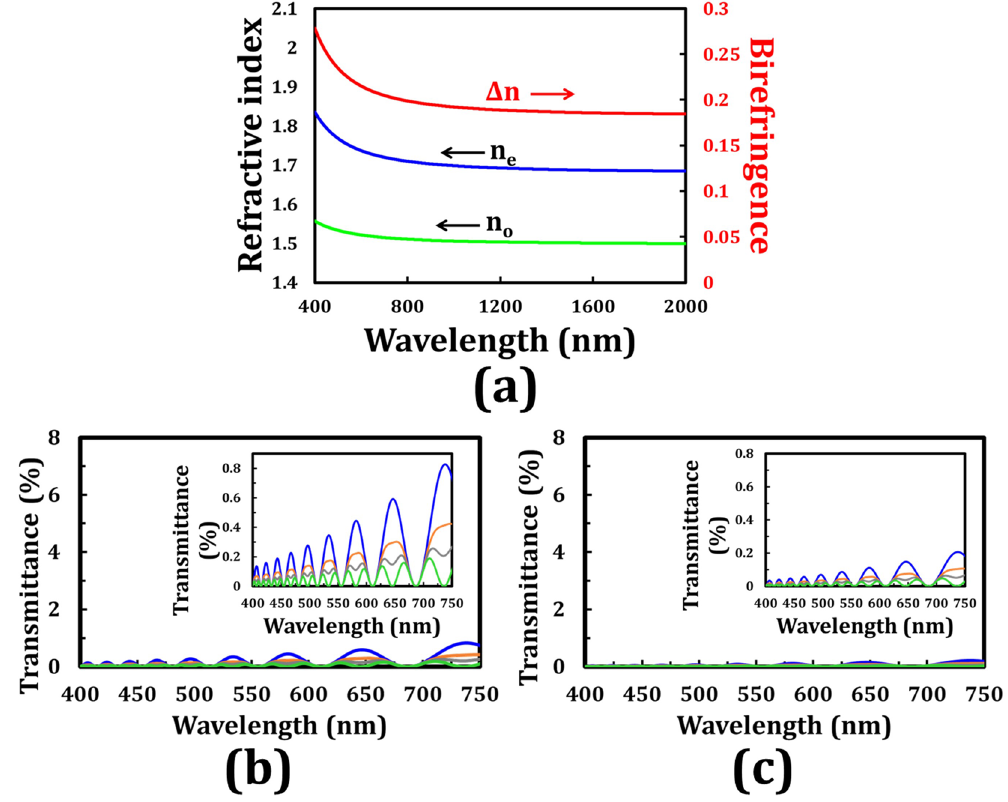
Figure 7. ( a ) Refractive index dispersion of the adopted LC (E7) based on Cauchy formula, where red, blue, and green curves represent the Δ n, n e , and n o , respectively. Theoretical transmittance (Jones Calculus) of the output beam through a tandem-2 φ -TNLC cell and an analyzer with its transmissive axis of 90° + 2 φ with respect to that of the polarizer ( β ) versus the wavelength of the input beam at different β angles with φ of ( b ) 45° and ( c ) 22.5°. Blue, orange, gray, and green curves represent the different β angles of 0°, 22.5°, 30°, and 45°, respectively. Insets evidently show the details of the spectra. The refractive index dispersion of the adopted LC (E7) for these theoretical analyses is